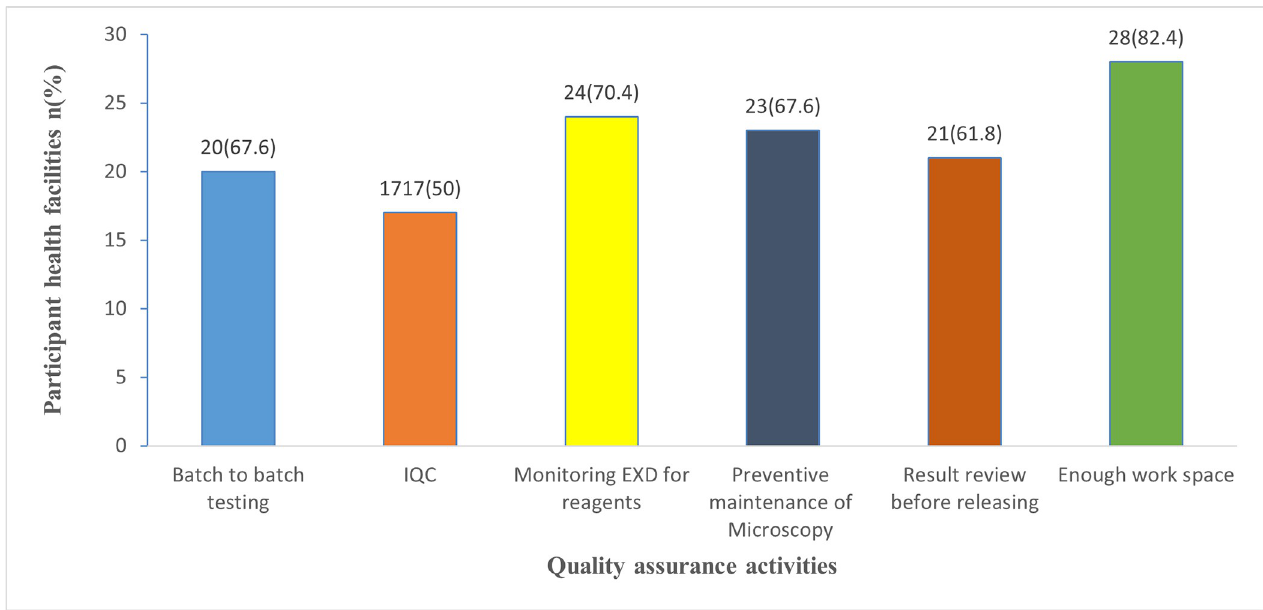
Fig 1. Practice of quality assurance activities for microscopy. EXD: Expiration Date; IQC: Internal Quality Control; n: Number of participant health facilities.